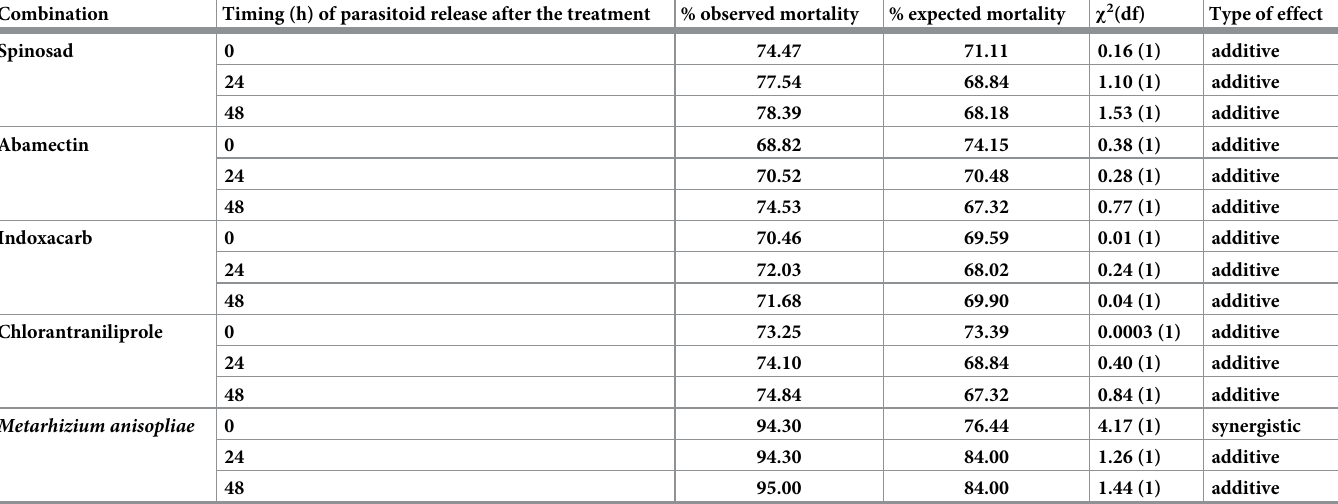
Table 3. The mortality rates of Tuta absoluta in an integrated system including the parasitoid Trichogramma brassicae + the entomopathogenic fungus, Metarhi- zium anisopliae , or the chemical insecticides spinosad, abamectin, indoxacarb and chlorantraniliprole. Combination Timing (h) of parasitoid release after the